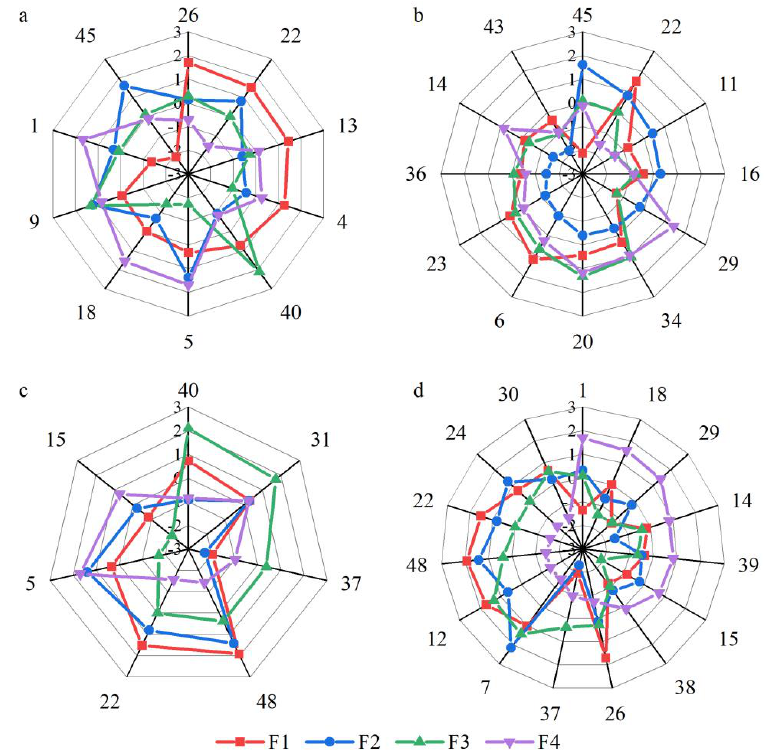
Figure 6. Average loadings for the distinguishing Statements of four factor. Note: The numbers in the Figure represent the order of the statements.